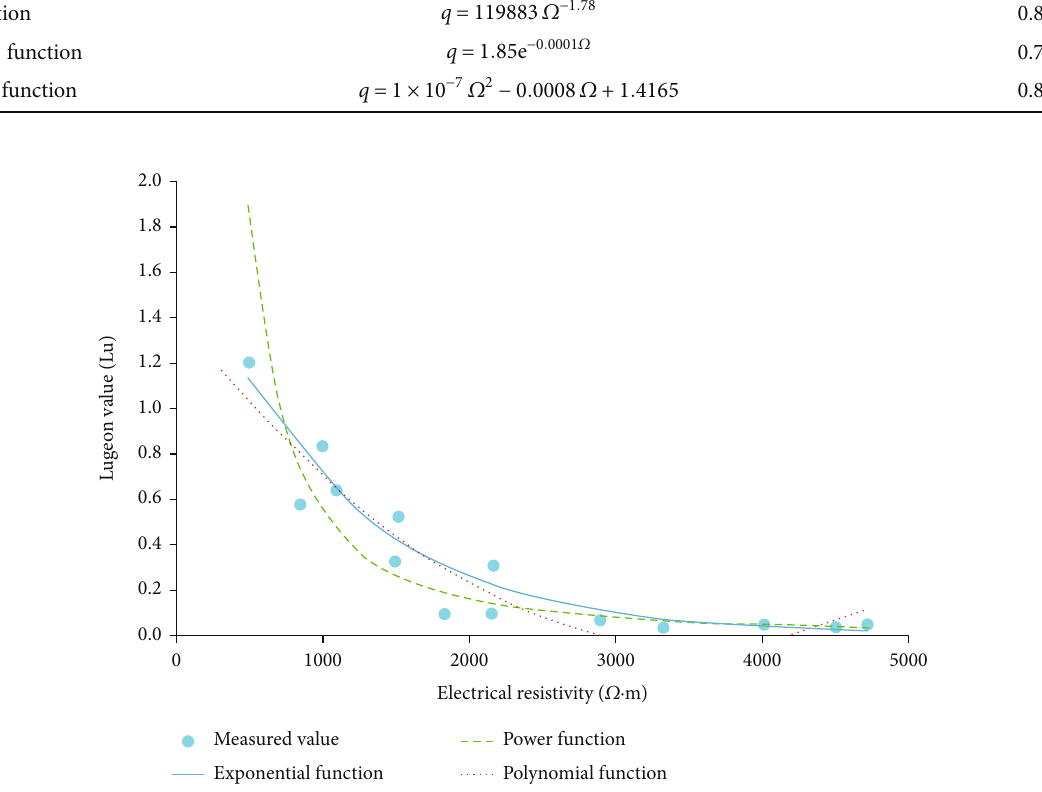
Figure 8: Borehole 1 model diagram of the relationship between electrical resistivity and Lugeon